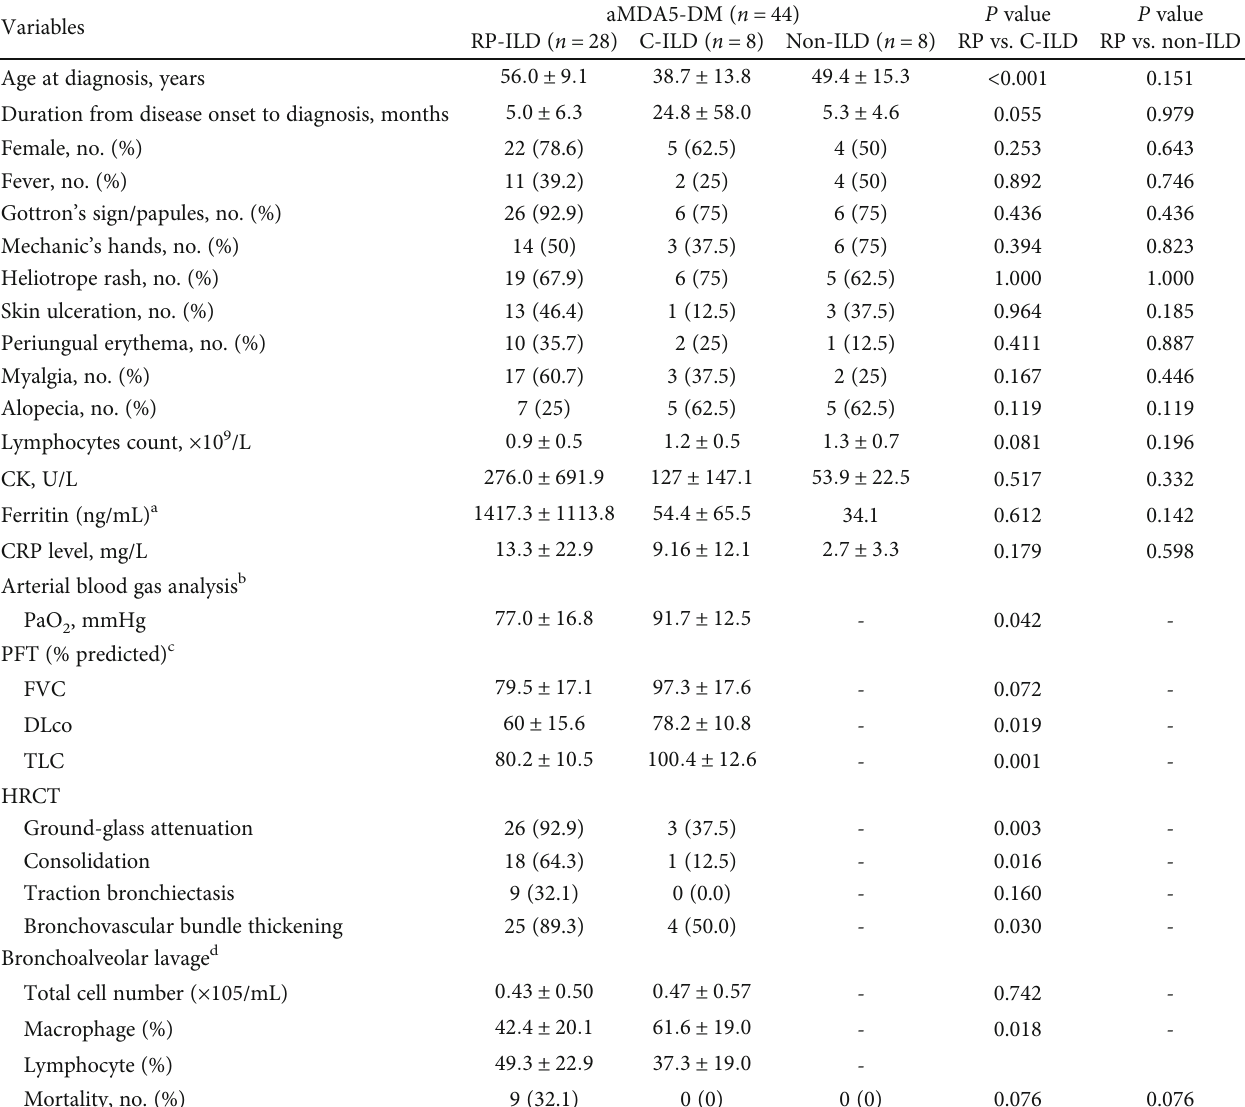
Table 2: Comparison of clinical and laboratory characteristics between the RP-ILD and non-RP-ILD groups in anti-MDA5-positive DM